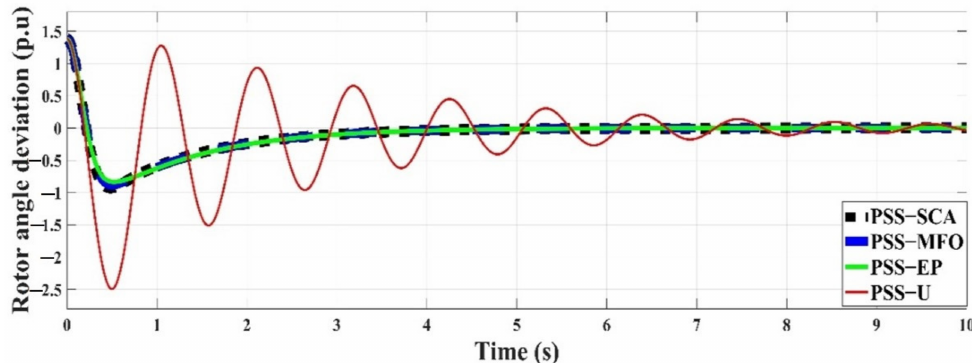
Figure 15. Rotor angle deviation for loading condition 5 of the SMIB with